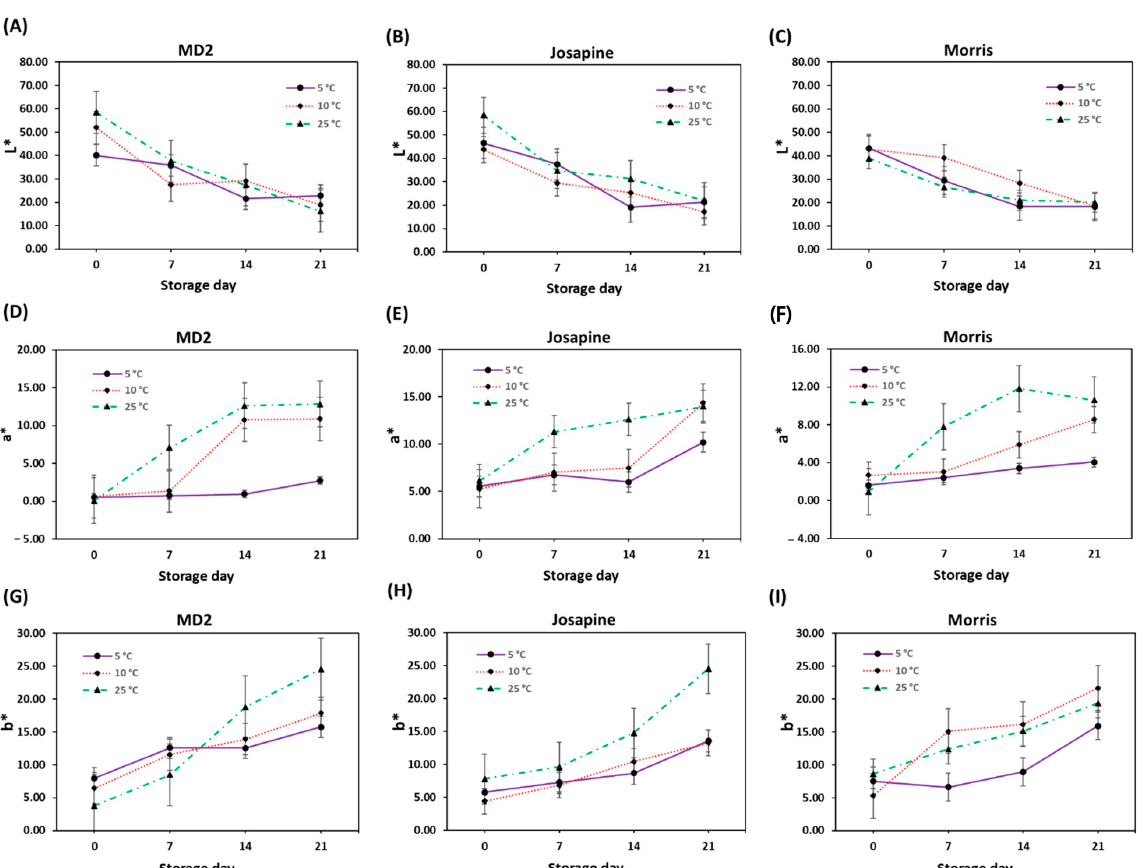
Figure 2. Colour changes in ( A ) L* for MD2, ( B ) L* for Josapine, ( C ) L* for Morris, ( D ) a* for MD2, ( E ) a* for Josapine, ( F ) a* for Morris, ( G ) b* for MD2, ( H ) b* for Josapine, and ( I ) b* for Morris at different storage temperatures.